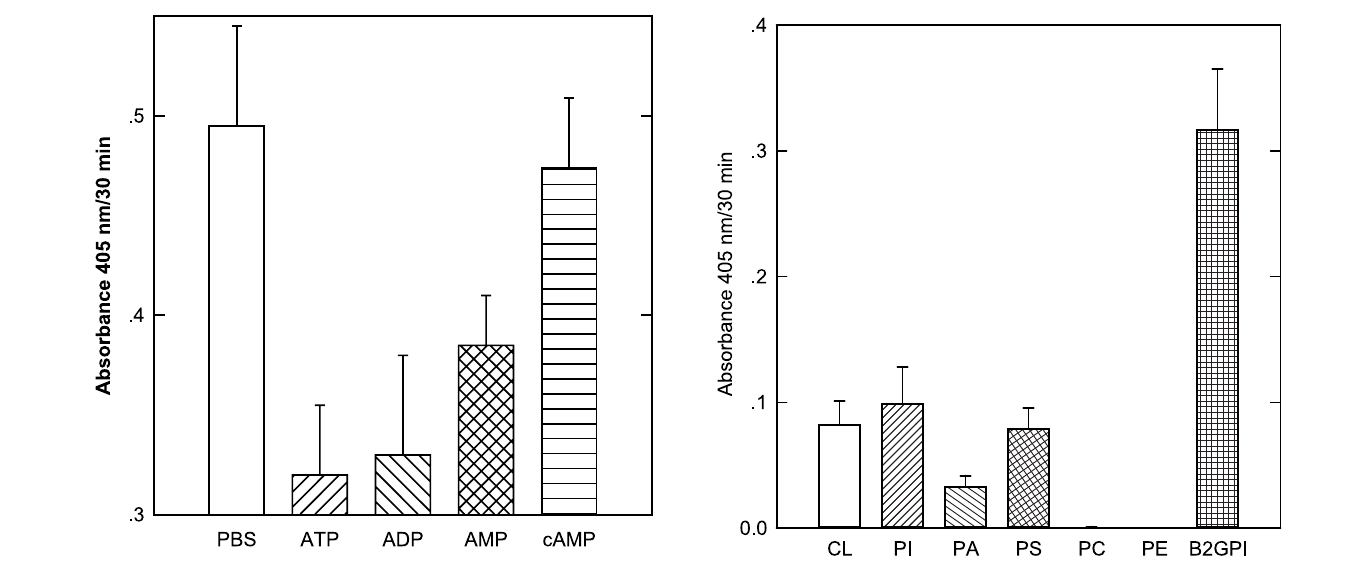
Figure 4. The binding of IgG to PA, measured in the serum of an APS patient (diluted 1:400 in phosphate buffered saline, PBS) and in the presence of 5mM concentrations of ATP, ADP, AMP and cAMP. The results are the means ^ SE of experiments performed in triplicate with one representative serum (of 5 tested).